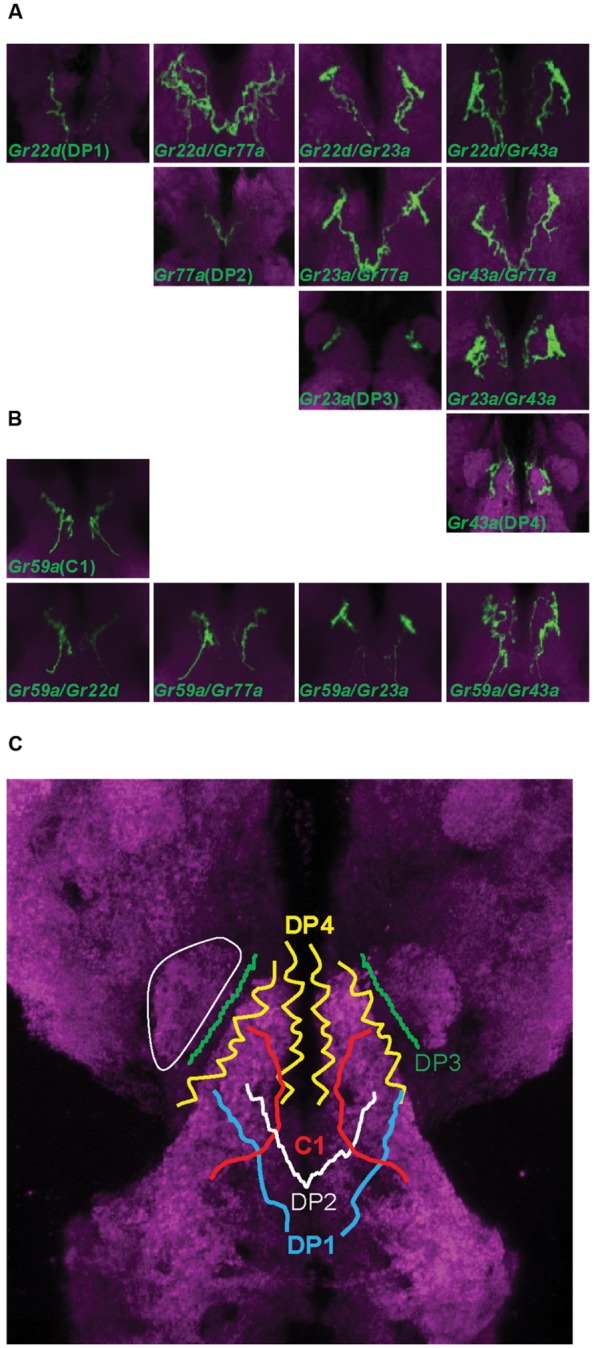
Projection patterns of dorsal pharyngeal GRNs in the larval brain. (A) Four Gr-GAL4 drivers that each express in a single pair of GRNs in the DPS were individually analyzed for projection patterns in the SOG of the larval brain, and also in pairs for double-driver analysis. The brain neuropil is counterstained with the monoclonal antibody nc82 (magenta). (B) Projection pattern of the Gr59a-GAL4 expressing GRN that specifically expresses in the C1 neuron of the terminal organ, and projection patterns of pairs of different dorsal pharyngeal GRN-expressing GAL4 lines with Gr59a-GAL4. (C) Schematic drawing of a projection map of taste information relayed to the larval brain. The relative position of each neuron is depicted based on the results of (A) and (B). One of the larval antennal lobes, which exist on both sides, is outlined with a thin solid white line.